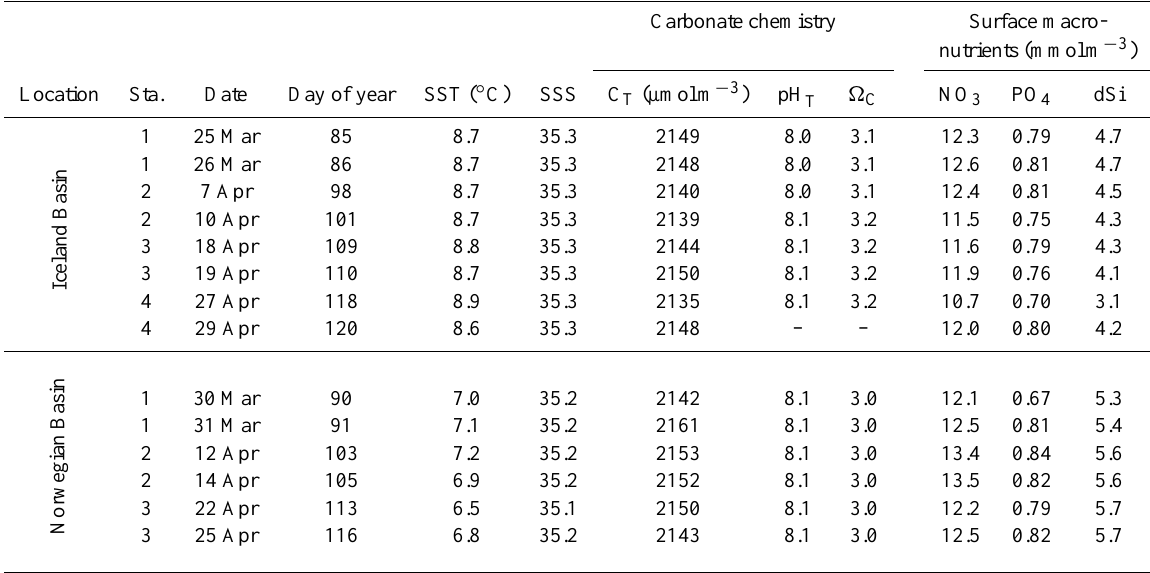
Figure 3. Seasonal variation in (a) satellite sea surface temperature (SST), (b) satellite daily incidental PAR, and day length and satellite Chl a for (c) the ICB and (d) the NWB for 2012. The grey region indicates the period of the cruise. The vertical dotted lines in plots (c) and (d) indicate bloom initiation, calculated following Henson et al. (2009). The insets in (c) and (d) show the variation in satellite chlorophyll during the period of the cruise. Table 1. Physicochemical features of the Iceland Basin and Norwegian Basin stations: Sta., station; SST, sea surface temperature; SSS, sea surface salinity; C T , dissolved inorganic carbon; (cid:127) C , calcite saturation state; NO 3 , nitrate; PO 4 , phosphate; dSi, silicic